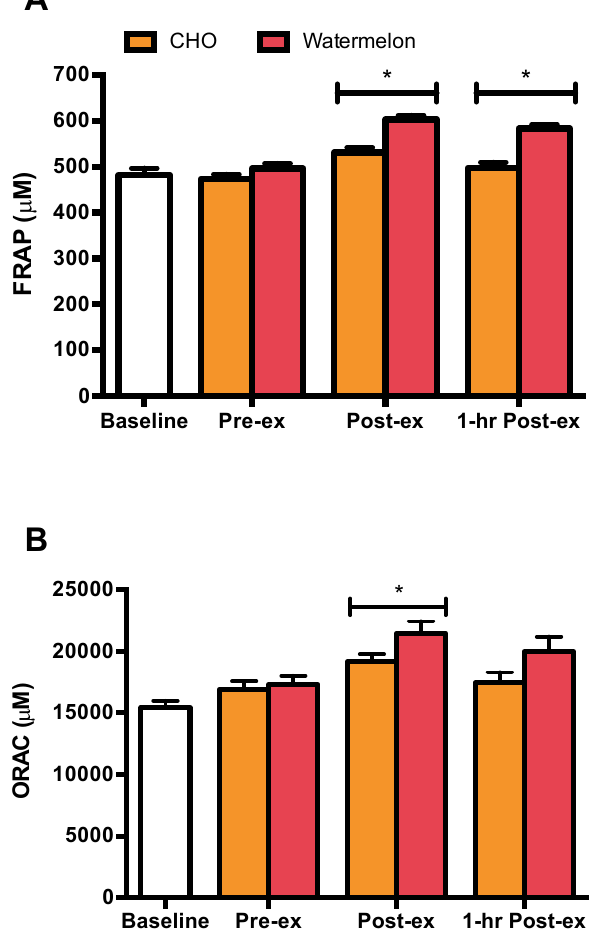
Figure 1. Watermelon consumption during exercise potentiates the exercise-induced increase in plasma antioxidant capacity. ( A ) Plasma FRAP = ferric reducing ability of plasma (expressed as ascorbate equivalents) and ( B ) plasma ORAC = oxygen radical absorbance capacity (expressed as trolox equivalents) were higher in WM compared to CHO following 75 km cycling (interaction effect, p < 0.001, each); * p < 0.0125 compared to time matched CHO.